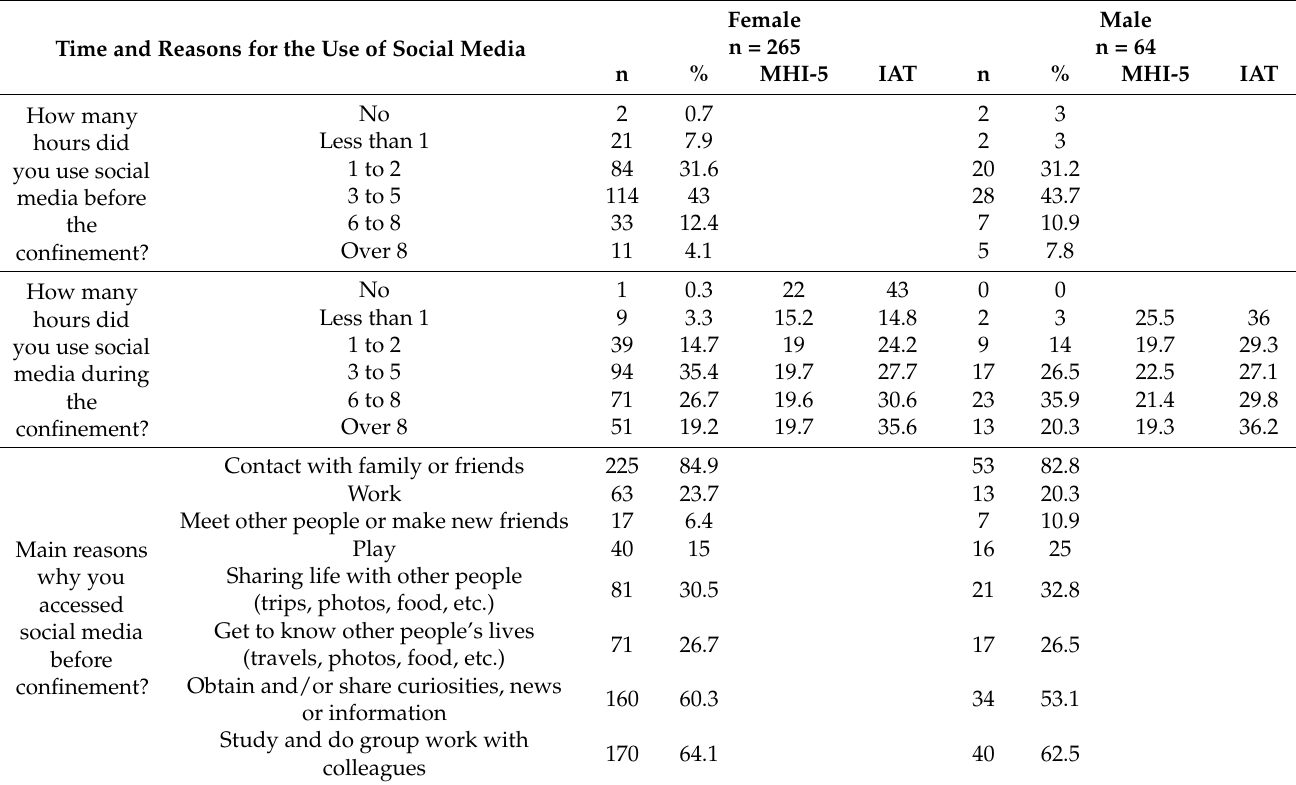
Table 7. Time and reasons for the use of social media before and during confinement COVID-19 and Mental Health and Internet